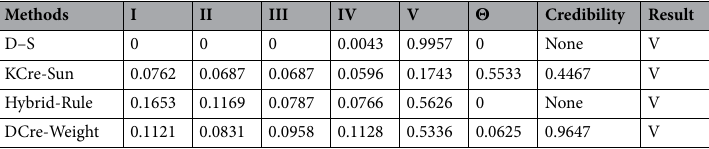
Table 4. Comparison with air quality evaluation methods using evidence combination rules.